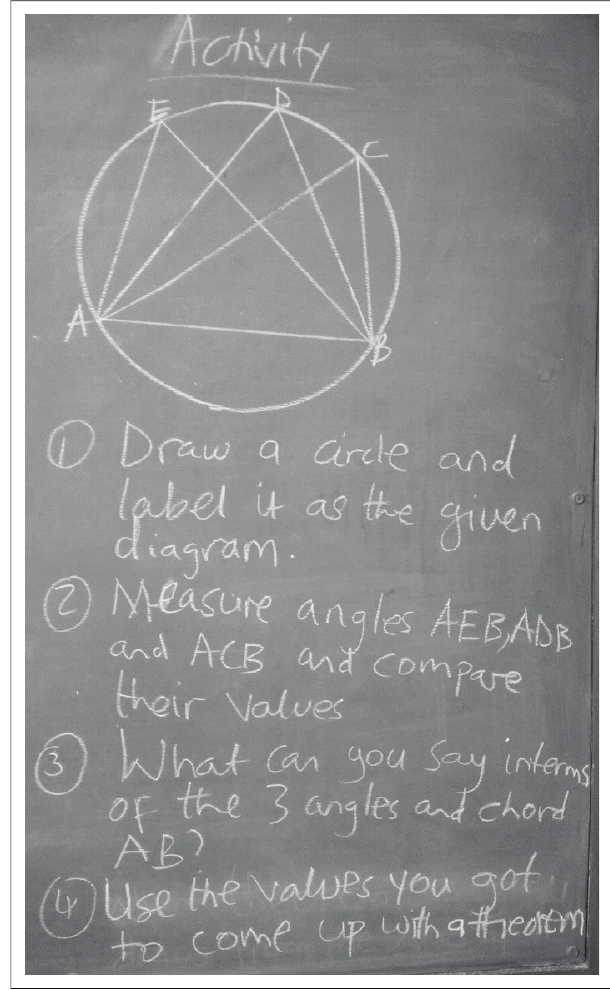
Source: Mwadzaangati, L.E.N. (2017a). An exploration of mathematical knowledge for teaching geometric proofs . Unpublished doctoral dissertation, University of Malawi, Zomba, Malawi (p. 201). Retrieved from http://repository.cc.ac.mw:8080/jspui FIGURE 5: Empirical exploration task on angle properties of the